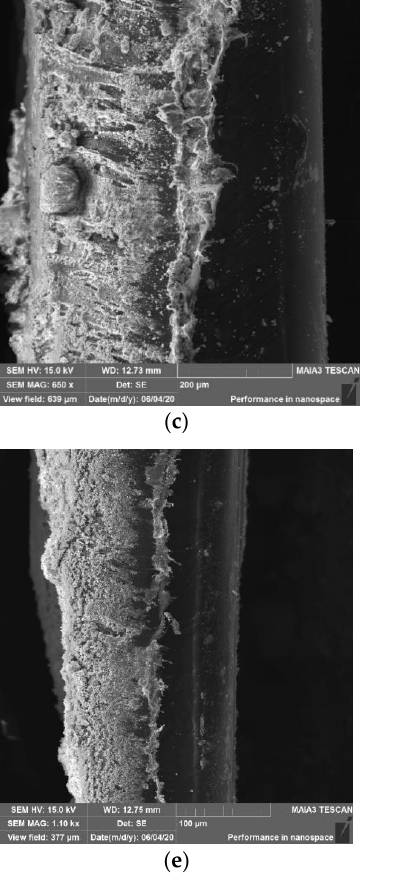
Figure 1. Cross-section ( a , c , e ) and surface ( b , d , f ) SEM micrographs of nanoparticles (NPs) immobilized onto linear low-density polythene (LLDPE) by thermal adhesion: CuNPs ( a , b ); Cu 2 ONPs ( c , d ); CuONP ( e , f ).